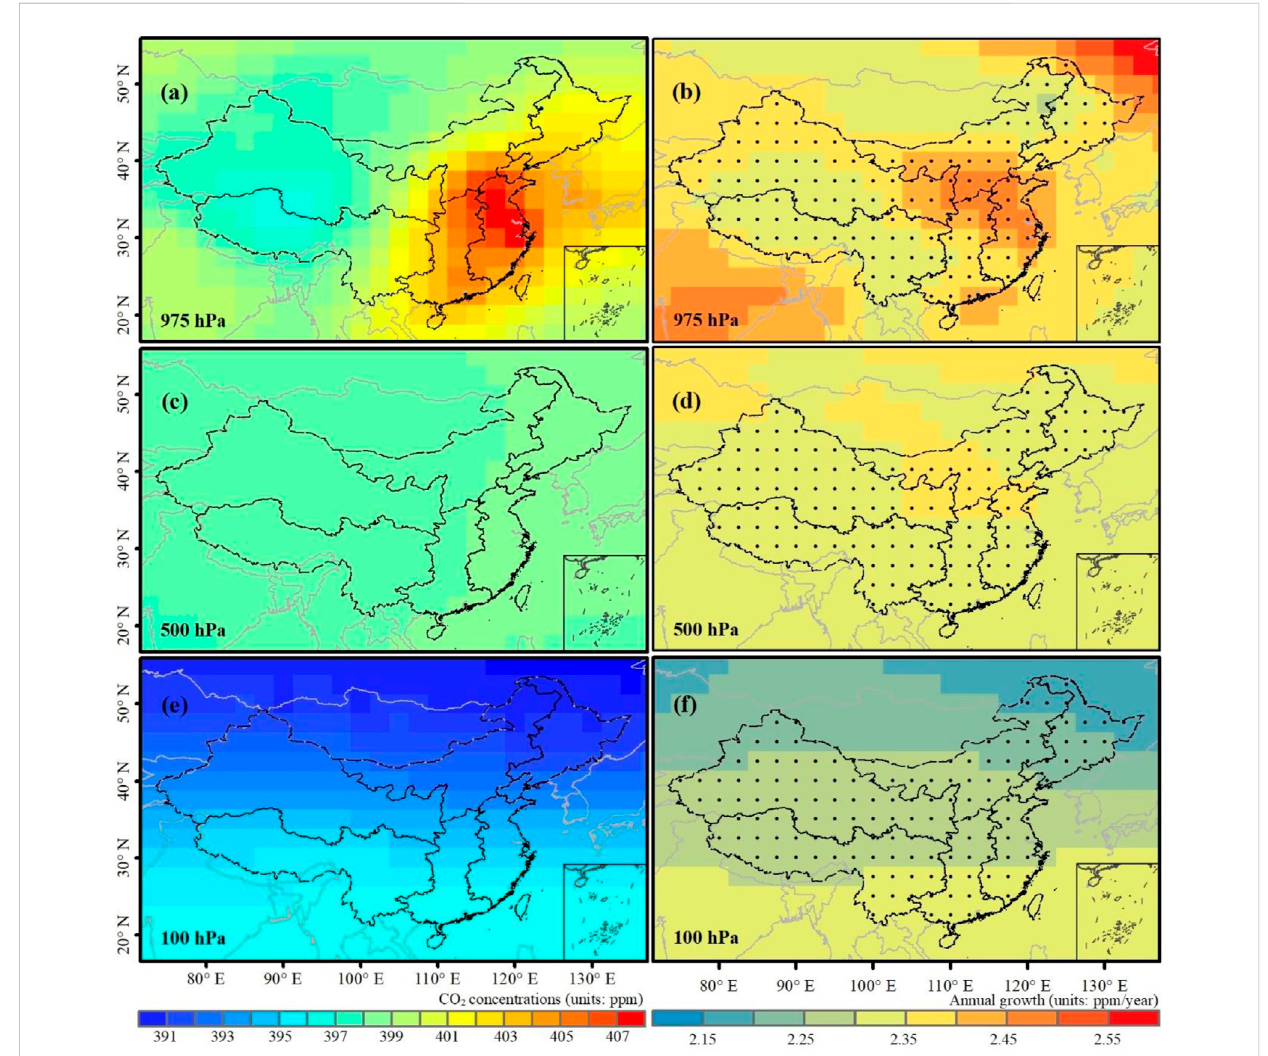
FIGURE 3 Spatial patterns of the annual mean (A, C, and E) and the change rates (B, D, and F) of CO 2 . It is to be noted that the grid cells fi lled with black dots indicate that the change rates are signi fi cant at the 95%